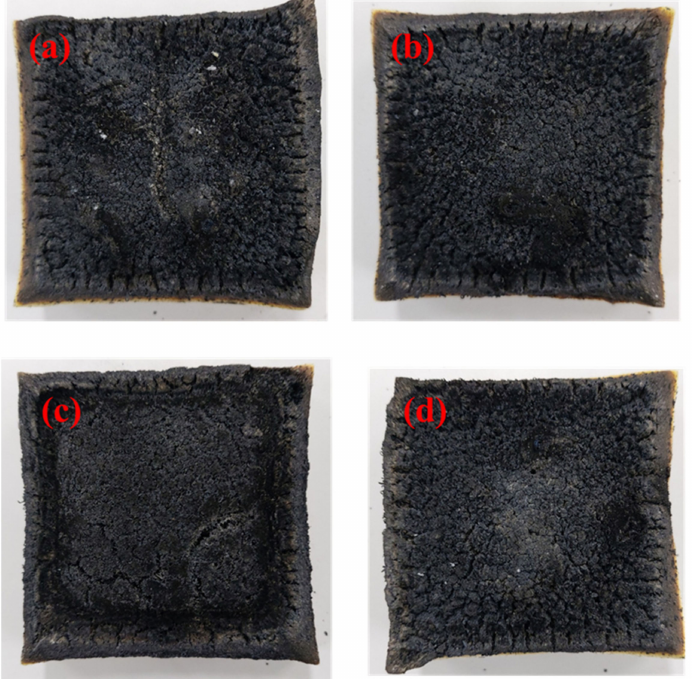
Figure 4. Digital photographs of combustion phenomenon of ( a ) neat RPU, ( b ) RPU/IFR0, ( c ) RPU/IFR1, and ( d )